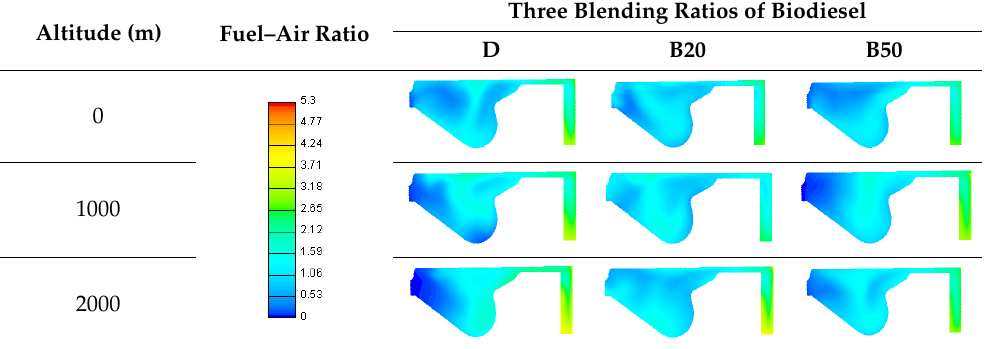
Table 4. Effect of plateau environment on distribution field of fuel–air ratio with three blending ratios.